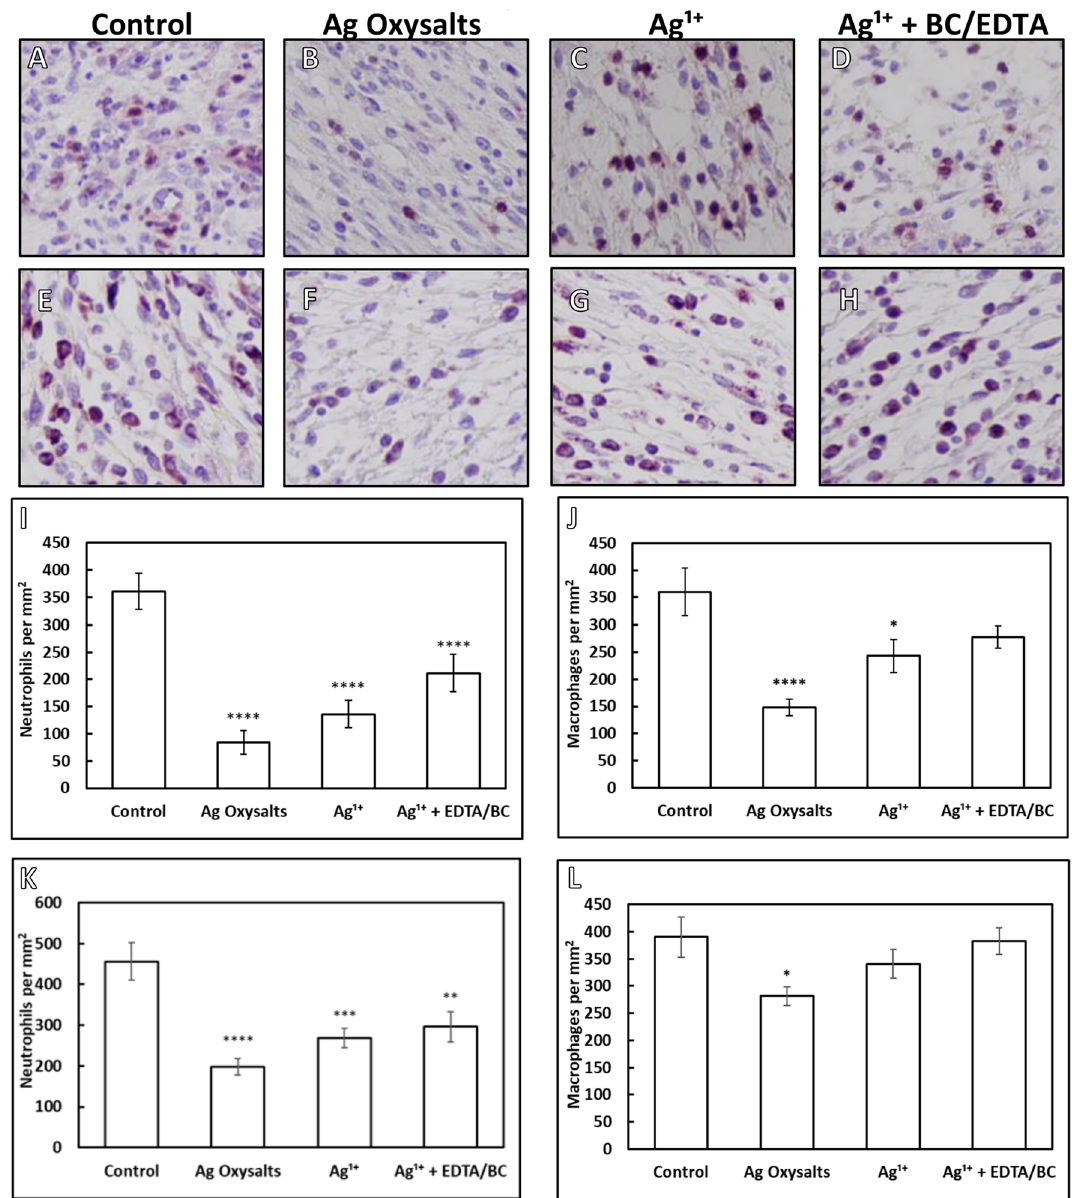
Figure 5. Quantification of neutrophils and macrophages in P. aeruginosa and S. aureus biofilm infected wounds after 3 days treatment with a non-antimicrobial control or silver dressings. Neutrophils ( A – D ) and macrophage ( E – H ) were quantified from histological sections stained with neutrophil or macrophage specific antibodies. Quantification of neutrophils ( I & K ) and macrophages ( J & L ) of P. aeruginosa ( I & J ) and S. aureus ( K & L ) biofilm infected wounds. N = 12 per group. Graphs show mean + /− standard error, significance values are in comparison to non-antibacterial control dressing, * indicates p = < 0.05; ** indicates p = < 0.01; *** indicates p = < 0.001; **** indicates p = < treatment with Ag Oxysalts dressings resulted in an average wound area of 2.35 mm 2 compared to 2.96 mm 2 in control-treated wounds, however this difference did not reach statistical significance ( p = 0.488) (Fig. 6I). In contrast, no reduction in wound area compared to the control was observed after treatment with Ag 1+ (3.38 mm 2 , p = 0.757) or Ag 1+ + EDTA/BC (4.18 mm 2 , p = 0.054) dressings. Increased re-epithelialisation was observed with Ag Oxysalts dressings compared to the control (30% vs 22%, respectively), although this did not achieve significance ( p = 0.067), it is highly suggestive and supports previous findings that Ag Oxysalts dressings promote re-epithelialisation of uninfected wounds 17 . In contrast, treatment with Ag 1+ or Ag 1+ + EDTA/BC dressings had no effect or exhibited a reduction in reepithelialisation compared to the control.